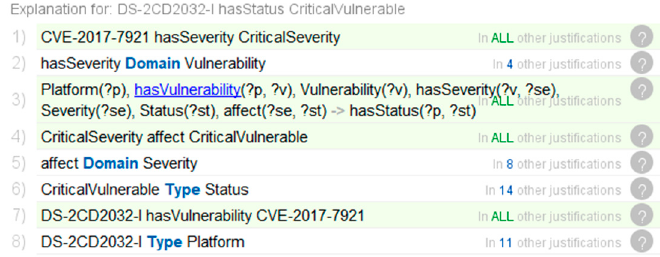
Figure 11. Inference process to infer the security status.